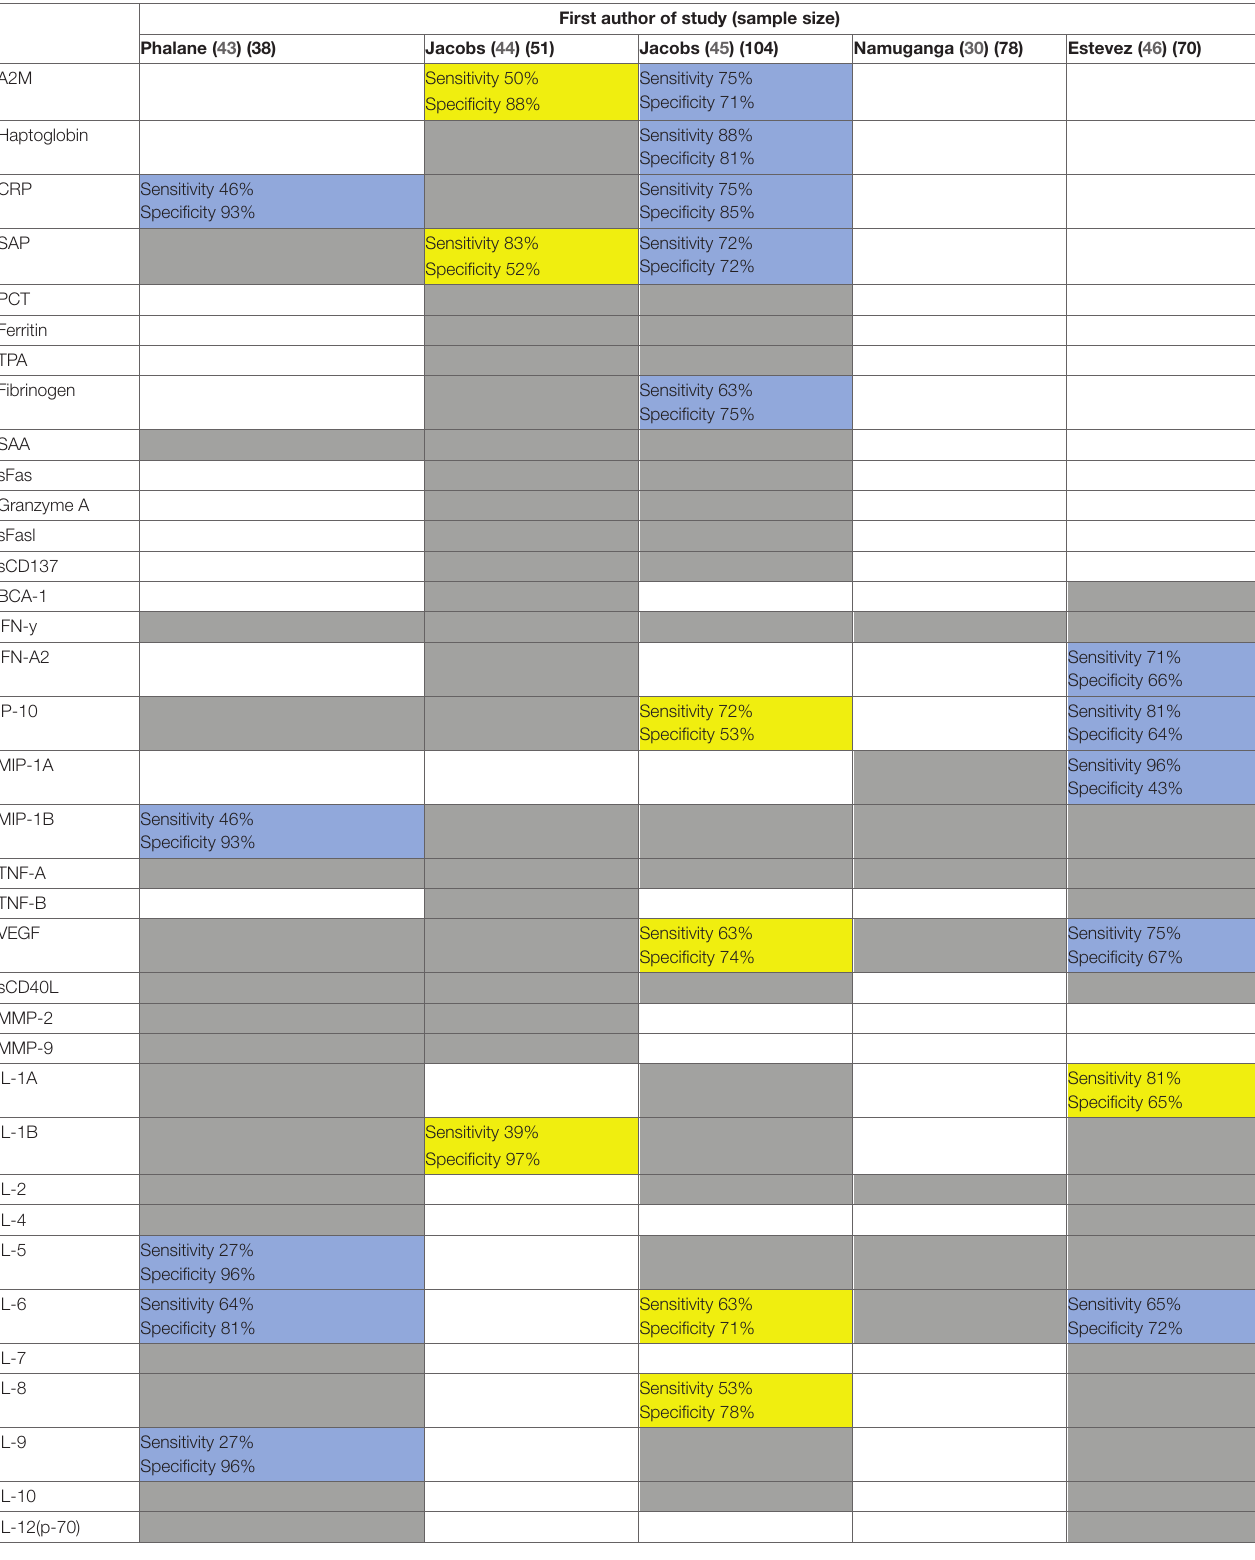
TABLE 1 | Summary of individual biomarkers analyzed in more than one study using Luminex bead-based multiplex